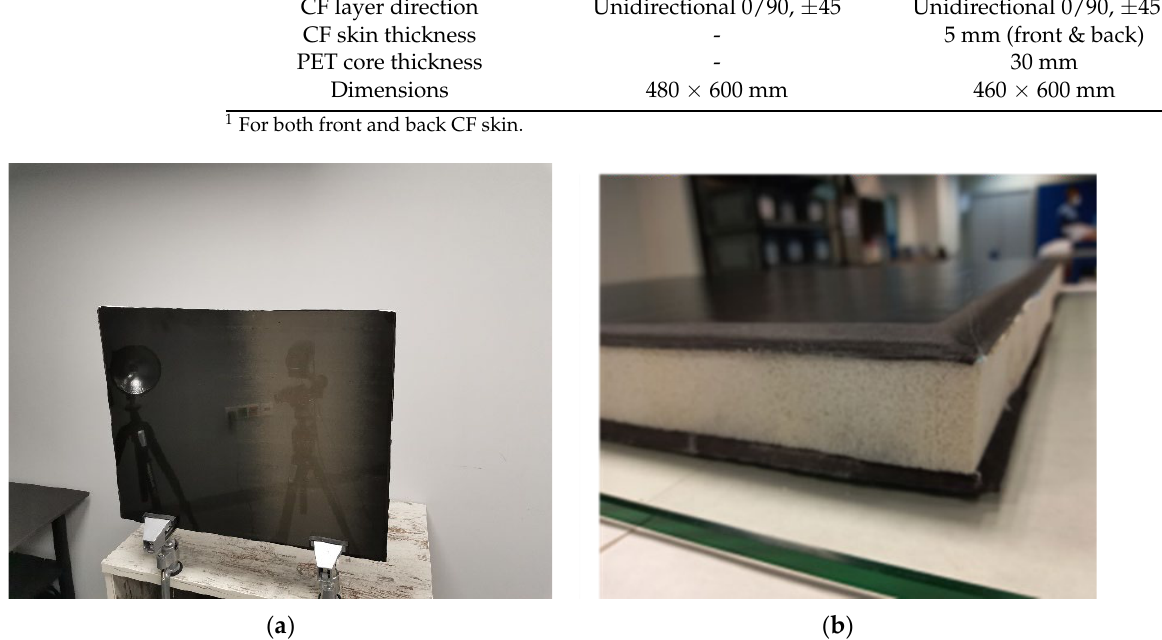
Table 2. Properties of the composite samples.